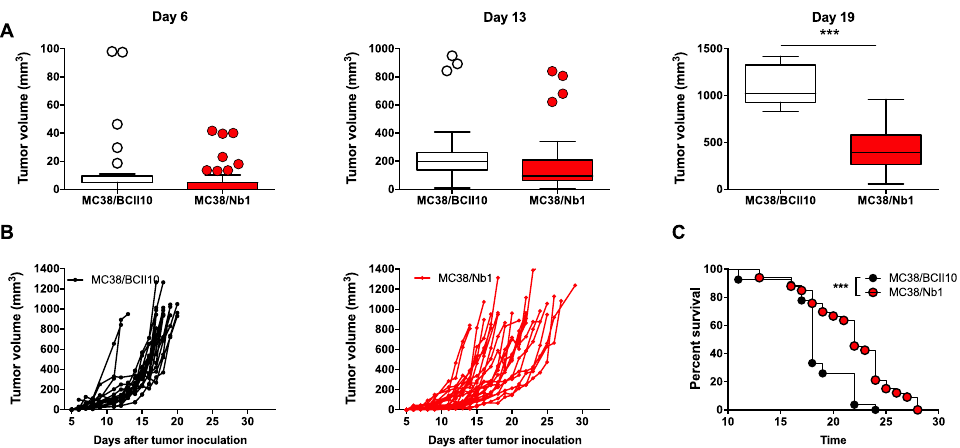
Figure 5. Local production of Nb1 delays MC38 tumor outgrowth in vivo. ( A – C ) MC38 / BCII10 or MC38 / Nb1 were grown at the lower back of C57BL / 6 mice. Growth of MC38 tumors was monitored on a daily basis. ( A ) The box and whisker graphs show the range, mean and standard deviation of the tumor volume on days 6, 13 and 19. ( B ) The graphs show the tumor growth in each individual mouse. ( C ) Mice were killed when tumors reached a volume of 993 ± 115 mm 3 . The time to reach this tumor size was plotted in a Kaplan–Meier curve and the log-rank test was used to determine p -values. ( A – C ) The graphs summarize the results of three independent experiments (mpc = 23 for BCII10 and 28 for Nb1). Statistical analysis was performed by the Student’s t -test for tumor growth and the log-rank (Mantel–Cox) test for the survival. Asterisks represent p < 0.001